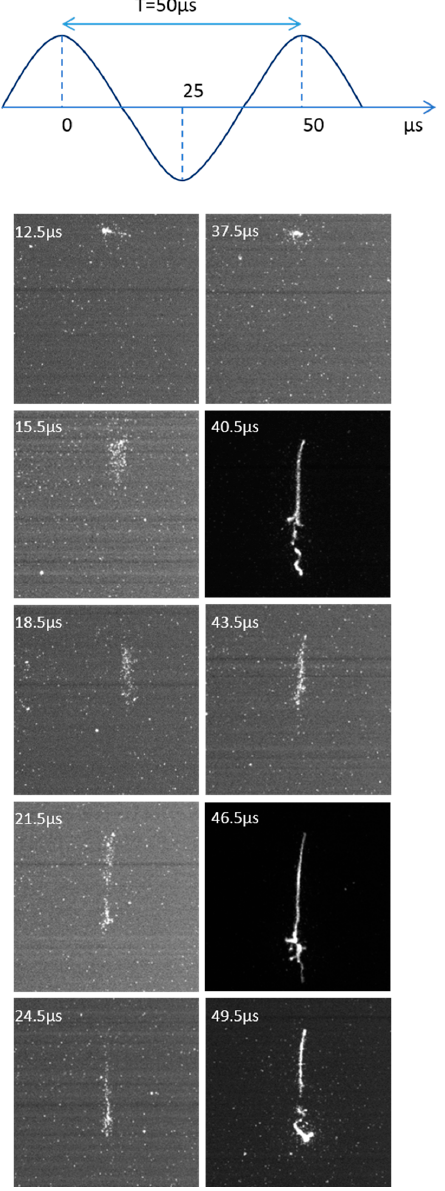
Figure 3. Plasma ionisation process. Propagation of a plasma bullet type of ionisation ( left ), from 12 µ s to 25 µ s, and formation of filaments ( right ), from 37 µ s to 50 µ